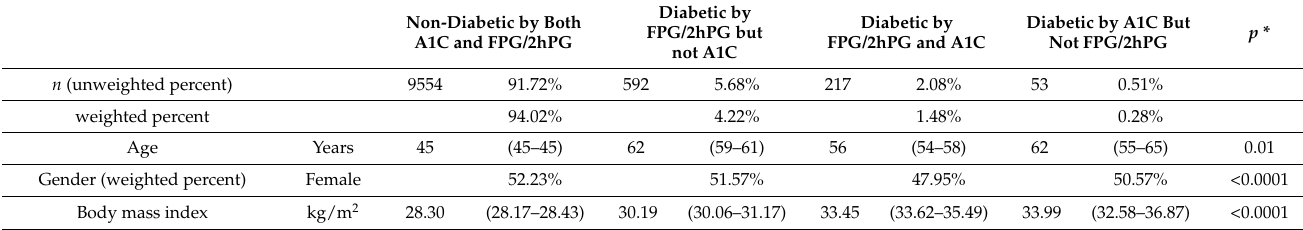
Table 3. Clinical characteristics by the diagnostic categories in subjects without a prior diagnosis of